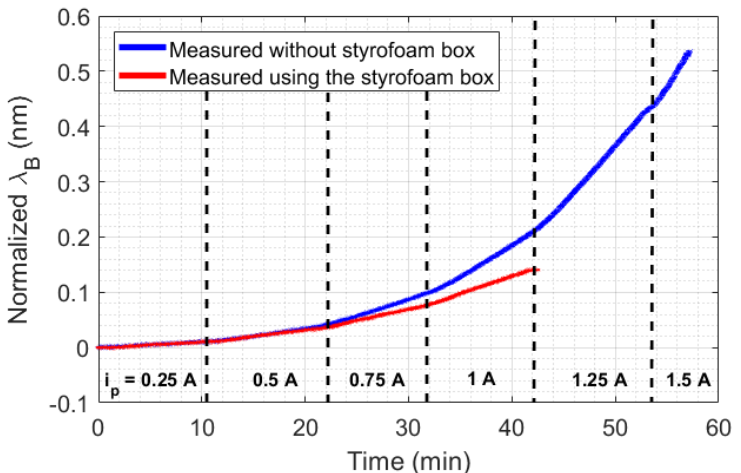
Figure 4. Experimental data collected in the beaker experiment. I p is the supply current of the Peltier.